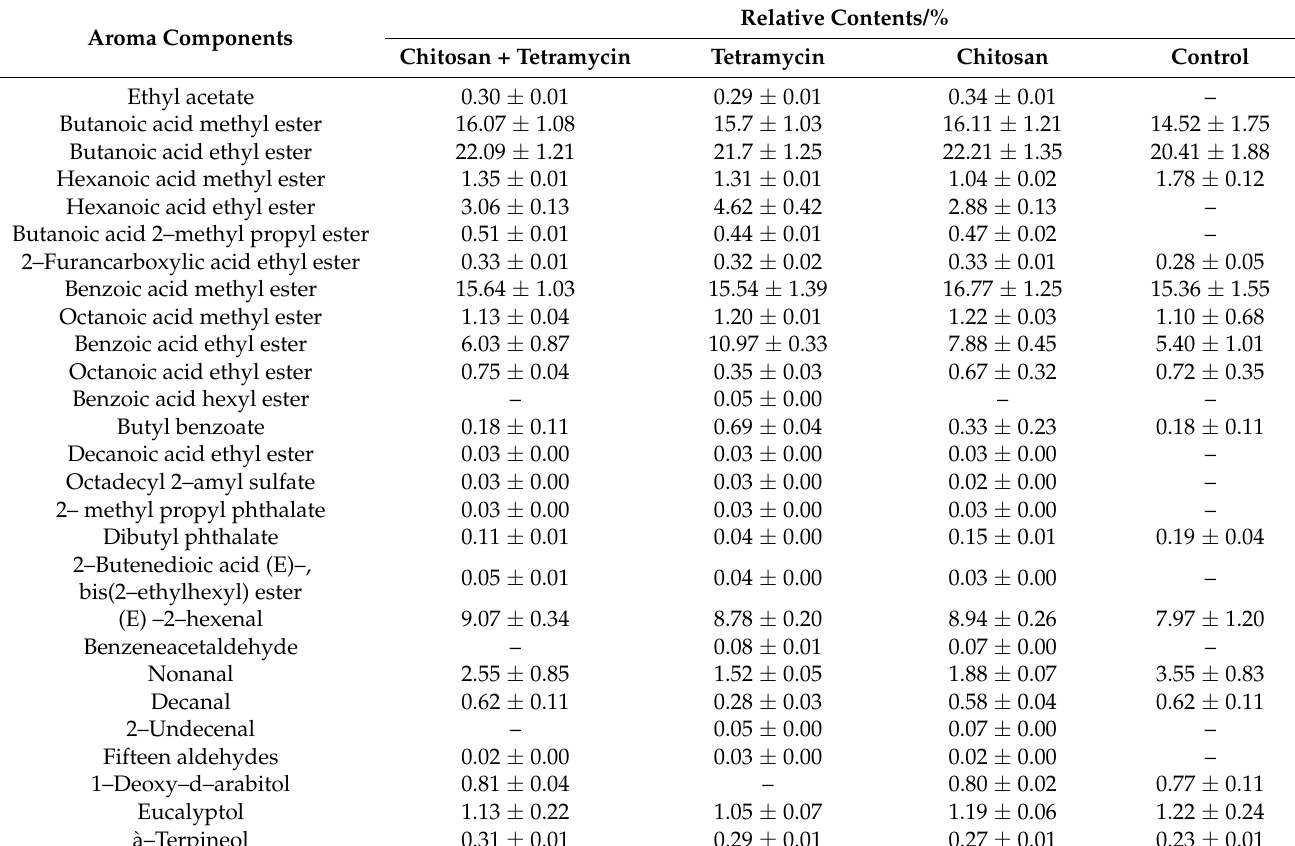
Table 5. The effects of chitosan and tetramycin on the aromatic compounds of